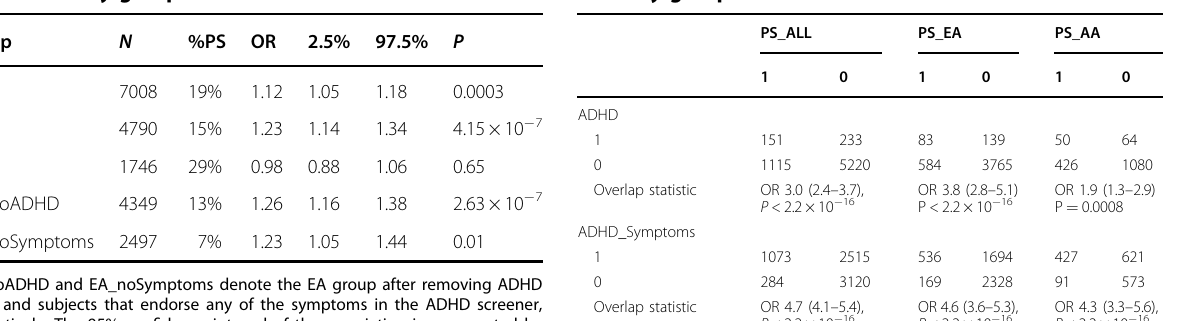
Table 1 Univariate association of ADHD PGS with PS across ancestry groups.